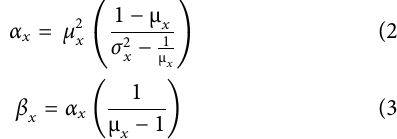
Frontiers in Earth Science |